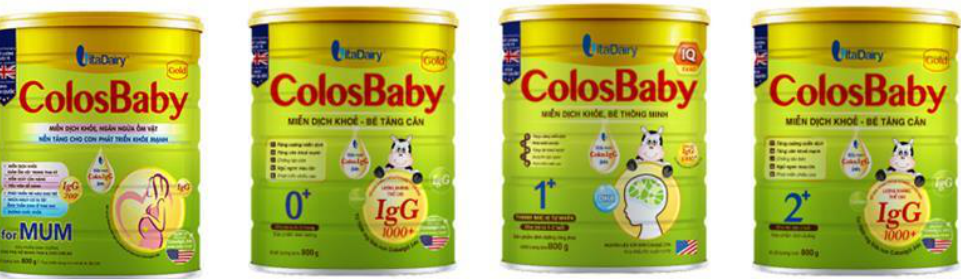
Figure 8. Cross-promotion of products in ColosBaby product line, with almost identical packaging and labeling